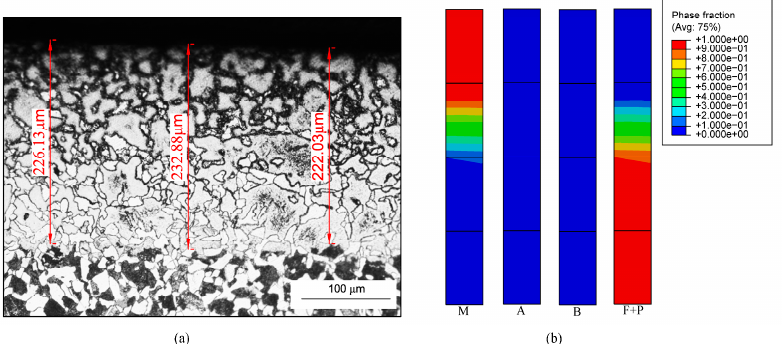
11 of 19 Figure 4. Microstructure distribution of the strengthened layer under no. 1 grinding parameter: ( a ) experimental result; ( b ) simulated result; ( c ) the complete strengthened layer; ( d ) the transition layer; ( e ) the boundary between the strengthened layer and the bulk region. Figure 5 and Figure 6 show the microstructure distribution of the strengthened layer under the